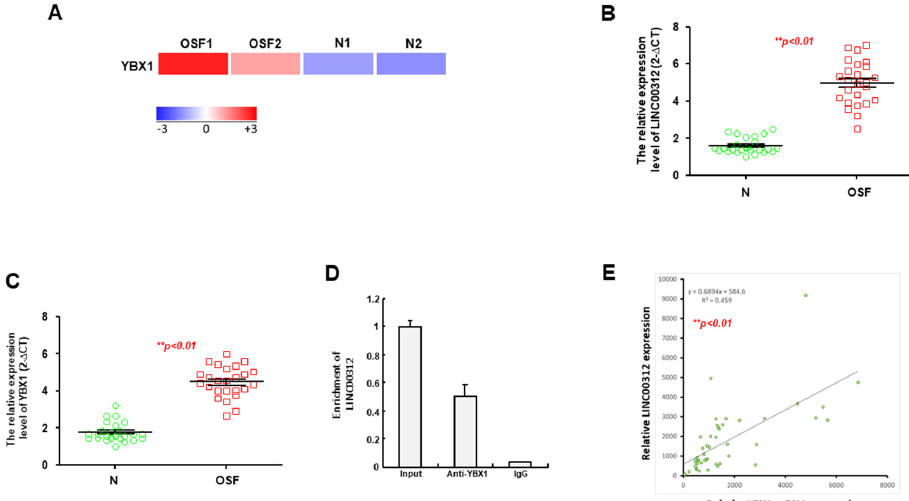
Figure 3. The Y-box binding protein 1 (YBX1) is a putative interacting factor of LINC00312. ( A ) YBX1 has been identified as one of the predicted interactomes of LINC00312 using the Rtool website. As shown in the lower panel, YBX1 was upregulated in the OSF tissues compared to the normal buccal mucosa by RNA-seq analysis. The increased expression of LINC00312 ( B ) and YBX1 ( C ) relative to the normal tissue in OSF specimens ( n = 25) were validated using qRT-PCR analysis. ( D ) The enrichment of LINC00312 was enriched in the anti-YBX1 group, compared to the control IgG group by an RIP assay. ( E ) The expression of LINC00312 was positively correlated with YBX1 expressions in OSF samples using Pearson’s correlation coefficient analysis.